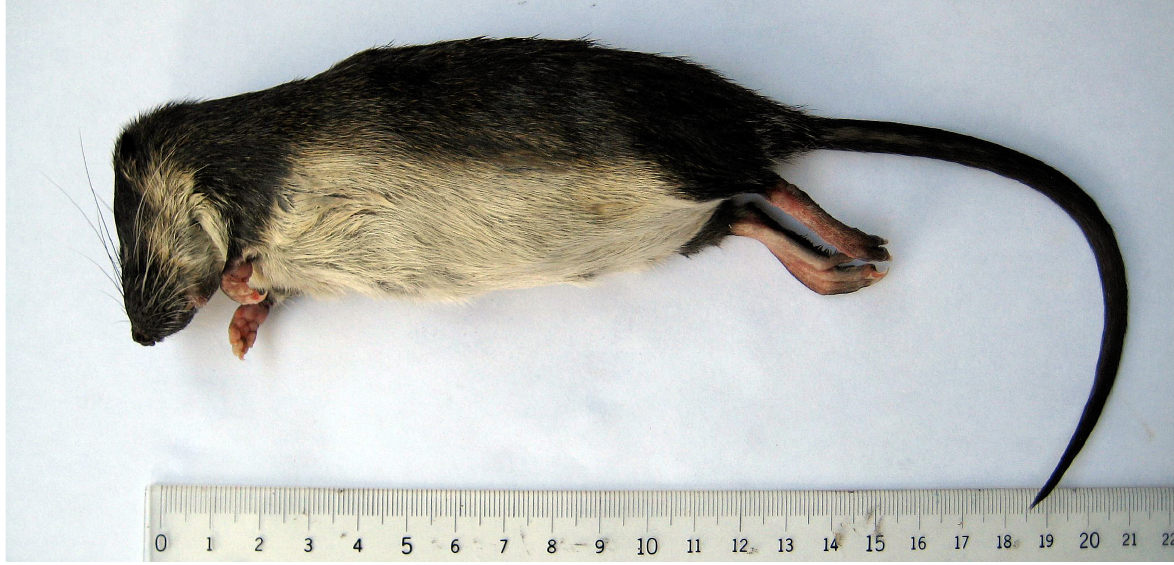
Figure 3. Fresh-dead wet specimen of Tweedy’s Crab-eating Rat, Ichthyomys tweedii (MNCR-M2106), collected in Quebrada Wilson, Las Cruces Biological Station, San Vito, Puntarenas Province, Costa Rica, on July